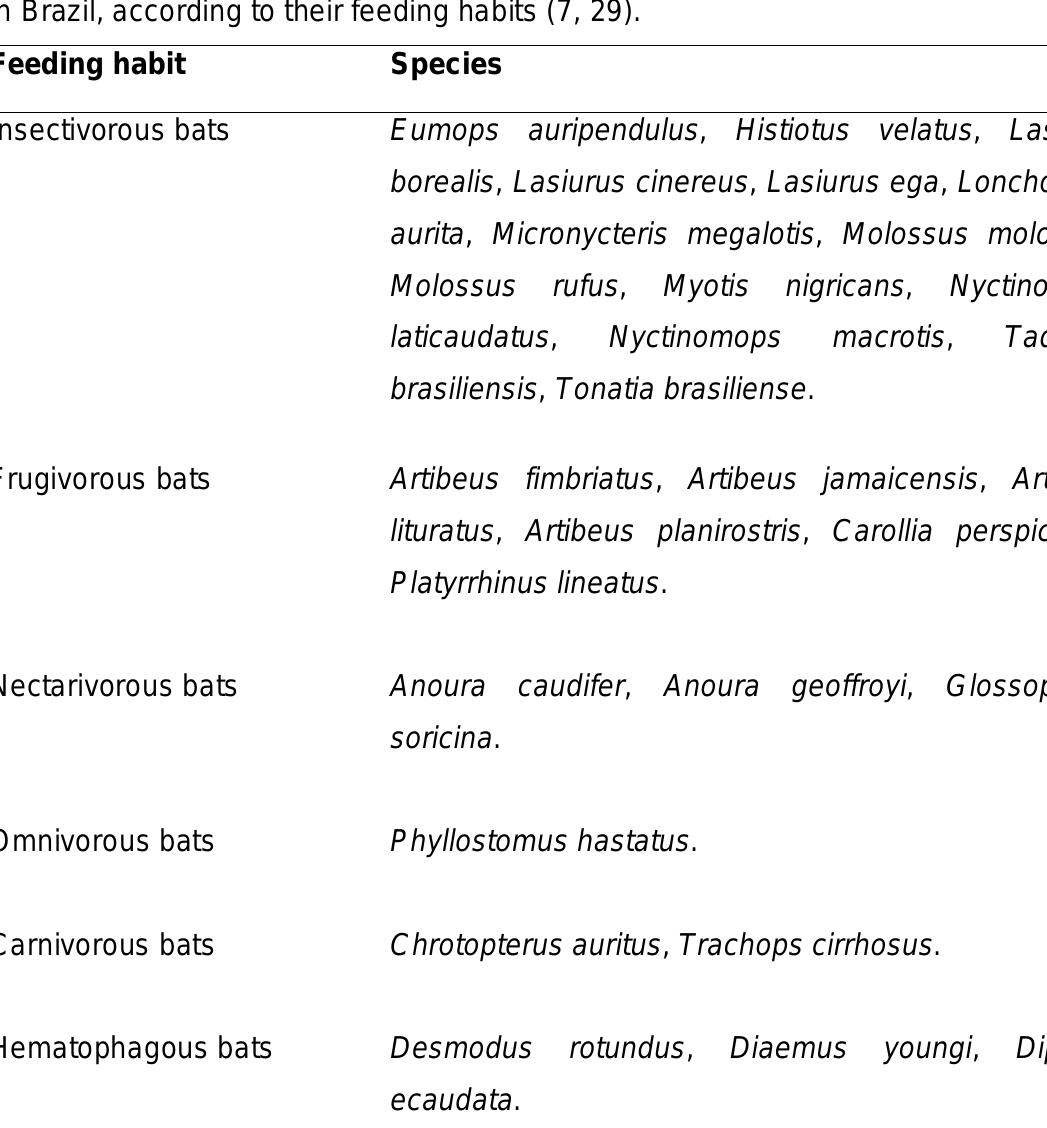
Table 2. Species of bats that have been found naturally infected with the rabies virus in Brazil, according to their feeding habits (7,